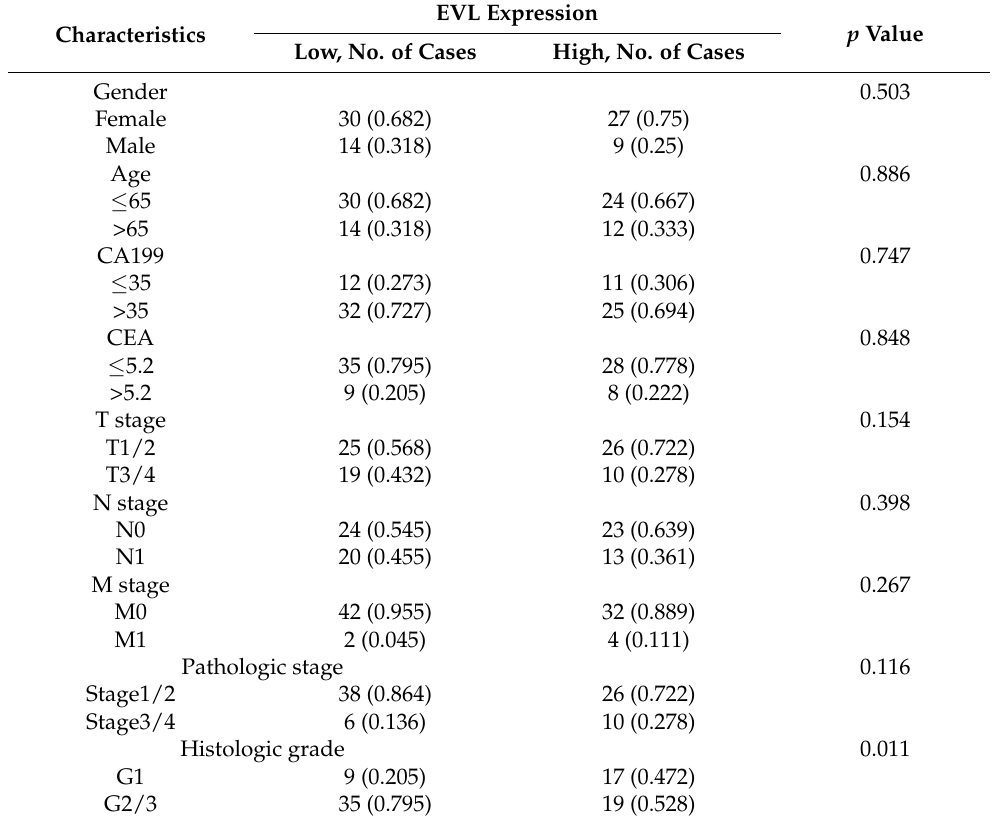
Table 1. Clinical characteristics of 80 PC patients.